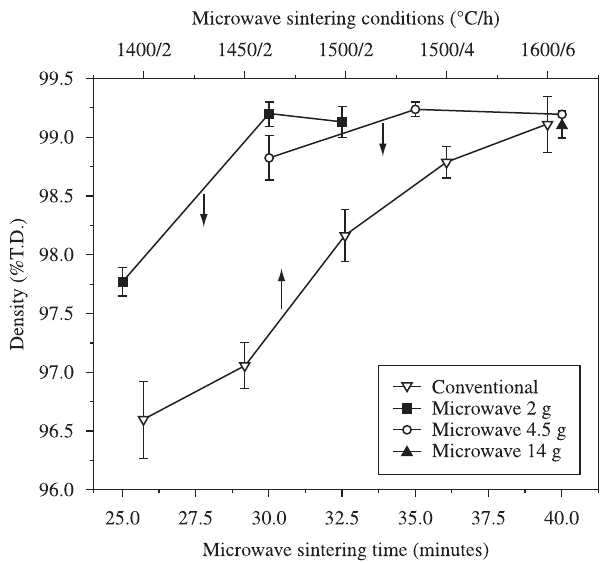
Figure 1. Relative density of microwave hybrid fast sintered and conventionally sintered alumina compacts.